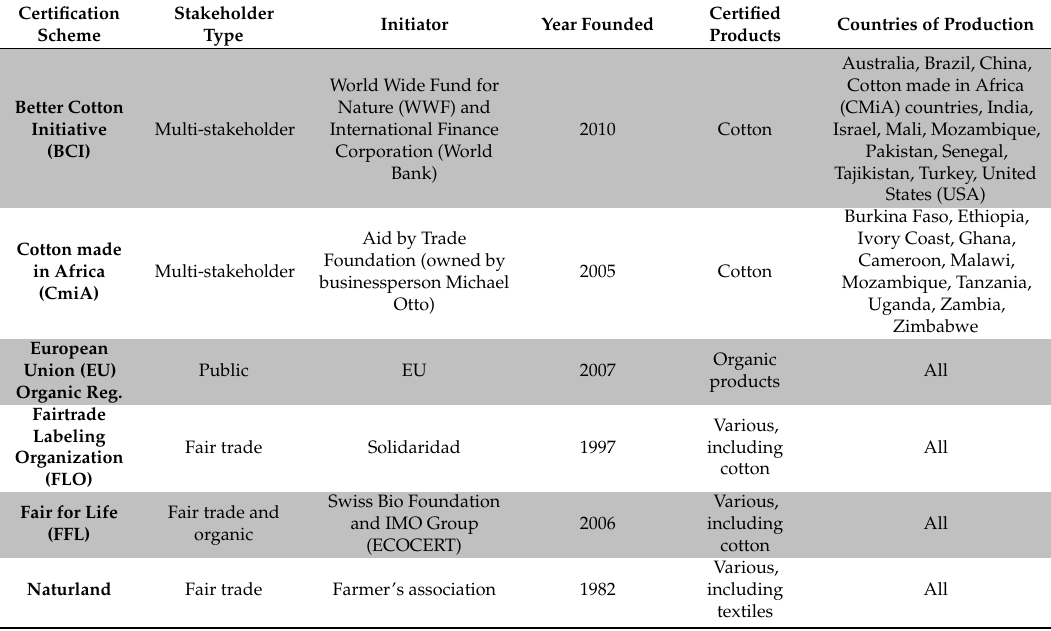
Table 1. Overview of certification